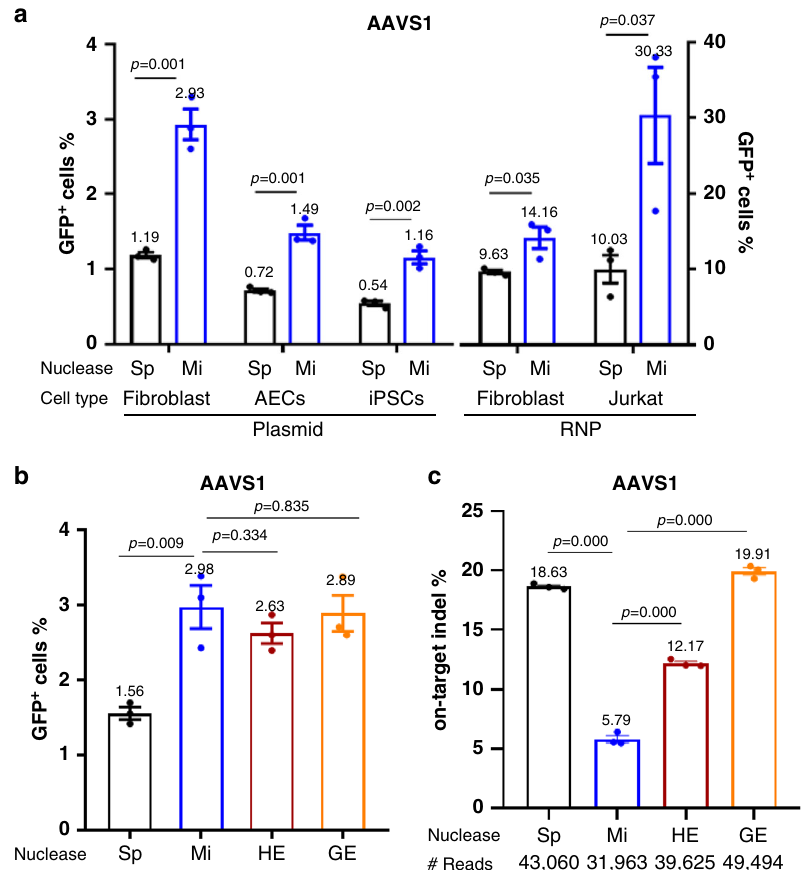
Fig. 2 MiCas9 increases KI rates and reduces on-target indel rates in ds-KI applications. a Percentage of GFP + cells after GFP ds-KI to the AAVS1 locus in different cell types. b Percentage of GFP + cells after GFP knock-in at the AAVS1 locus using different nucleases. c On-target indel rates at the AAVS1 locus after GFP ds-KI using different nucleases. AEC: airway epithelial cells, iPSCs: induced pluripotent stem cells, RNP: Cas9/gRNA ribonucleoprotein, Sp: spCas9, Mi: miCas9, HE: Cas9-HE, GE: Cas9-GE. # Reads: Average amplicon reads per sample. Three independent experiments were performed for each condition. Data are presented as mean ± standard error of means (SEM). Unpaired t- test (two tailed) was used to compare data using GraphPad Prism 8 software (GraphPad Software, Inc., San Diego, CA). Source data are available in the Source Data fi